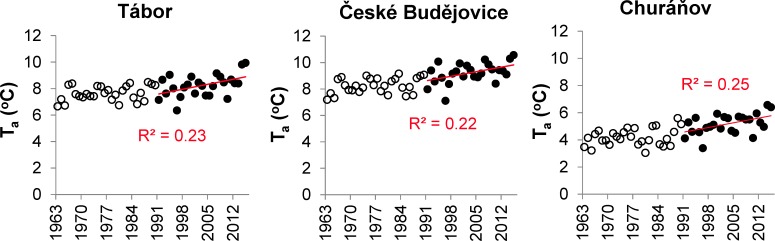
The annual air temperature (Ta) measured at meteorological stations in South Bohemia (1963–2015).Open and black points correspond to the years 1963–1990 and 1991–2015, respectively; regression lines indicate significant linear trends (p < 0.05) during 1991–2015.